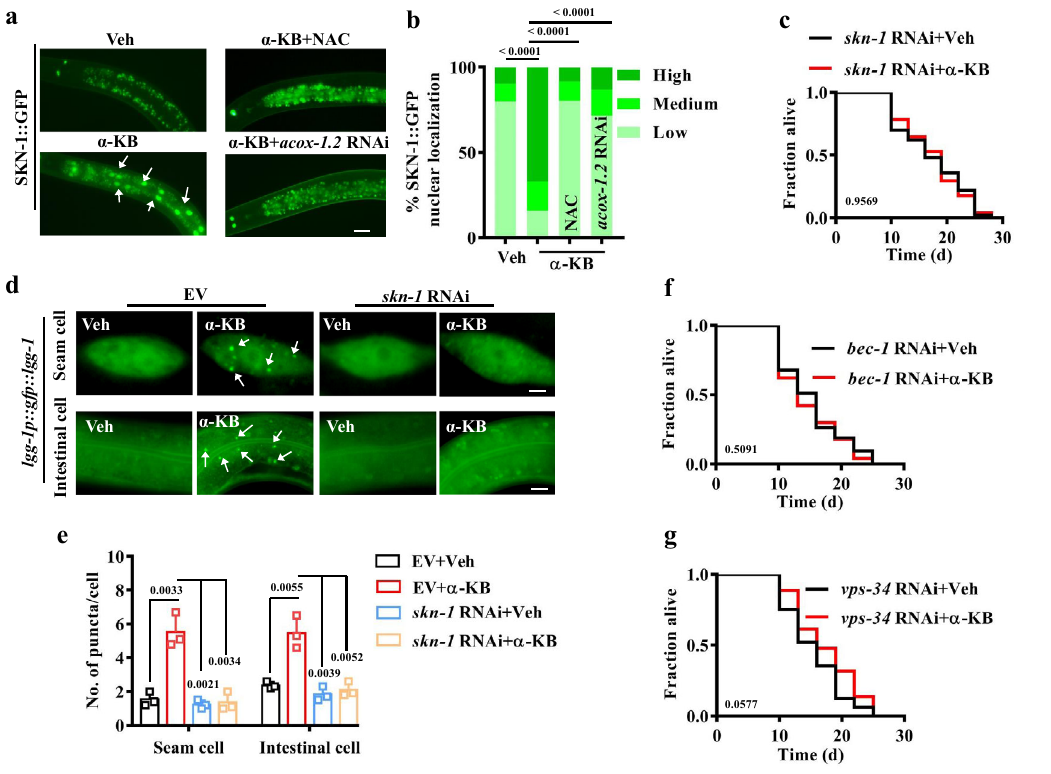
Fig. 5 | SKN-1-mediated autophagy is crucial for α -KB-induced lifespan exten- sion. a Representative images of SKN-1::GFP translocation. Veh vehicle. Scale bars: 20 μ m. b Quanti fi cation of SKN-1 nuclear accumulation. Supplementation with α - ketobutyrate ( α -KB, 500 μ M) promoted nuclear translocation of SKN-1::GFP in the intestine of worms, which was inhibited by treatment of N -acetylcysteine (NAC, 5mM) or knockdown of acox-1.2 by RNAi. Data were presented as mean values± SEM of three independent experiments ( n =35 worms per experiment). P values were calculated using the Friedman test (with Dunn ’ s test for multiple compar- isons). c Knockdown of skn-1 by RNAi suppressed the lifespan of wild-type (WT) worms treated with α -KB (500 μ M). P value was calculated using a log-rank test.